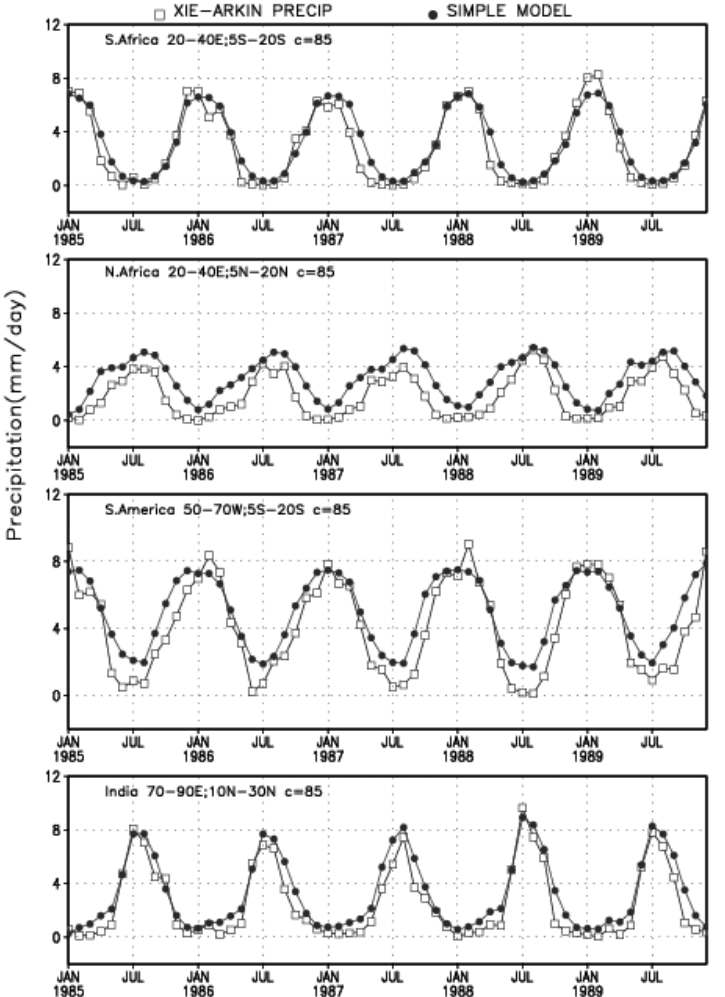
Fig. 2. Seasonal variation of precipitation in large tropical continents from the simple model (Eq. (11) and observations (Xie and Arkin, 1997) during 1985–1989.